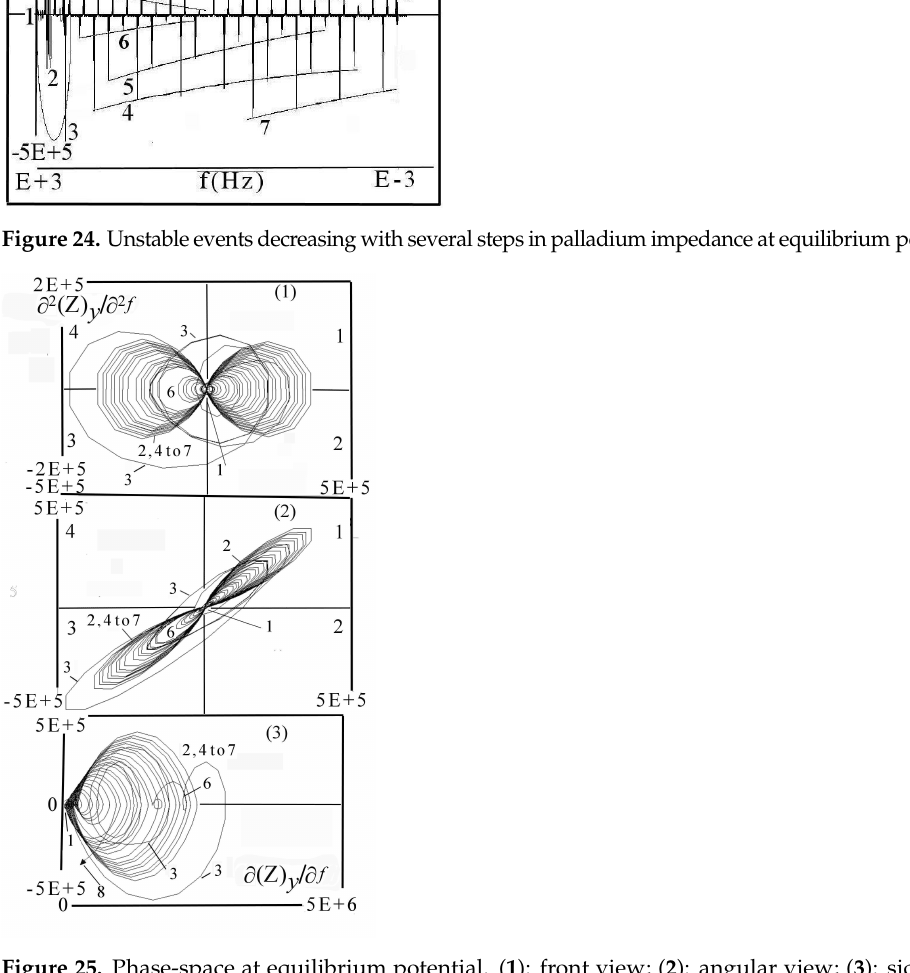
Figure 25. Phase-space at equilibrium potential. ( 1 ): front view; ( 2 ): angular view; ( 3 ): side view. Closed three-scrolls in combined repulsors (events 4–5) and attractors (events 2–3), a jump (event 7), and open-route (event